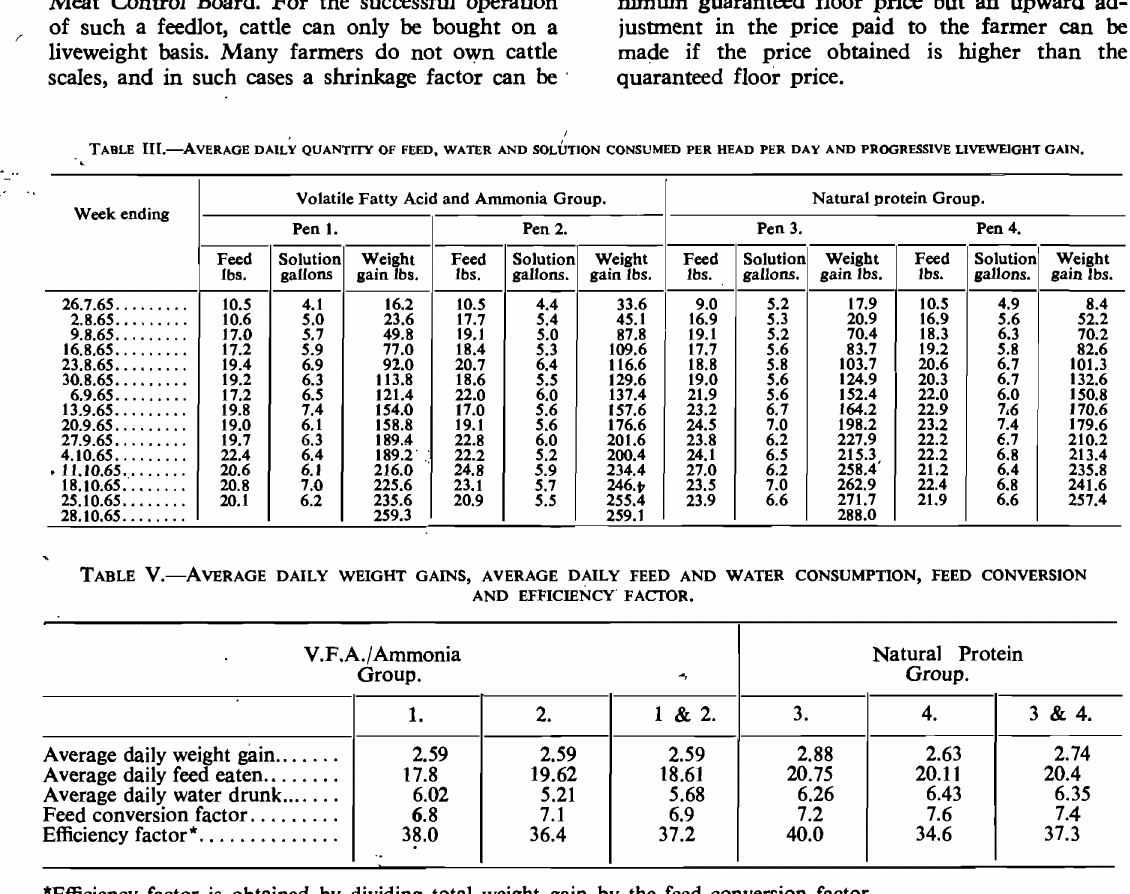
TABLE VI.-THE SLAUGHTER WEIGHTS, DRESSING PERCENTAGES, FAT AND MARBLING